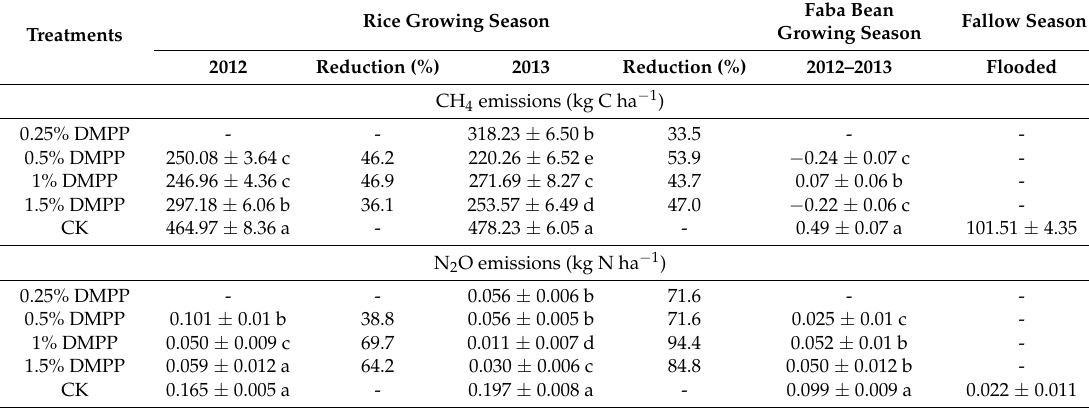
Table 1. Seasonal cumulative CH 4 and N 2 O emissions under different treatments in the paddy fields in 2012 and